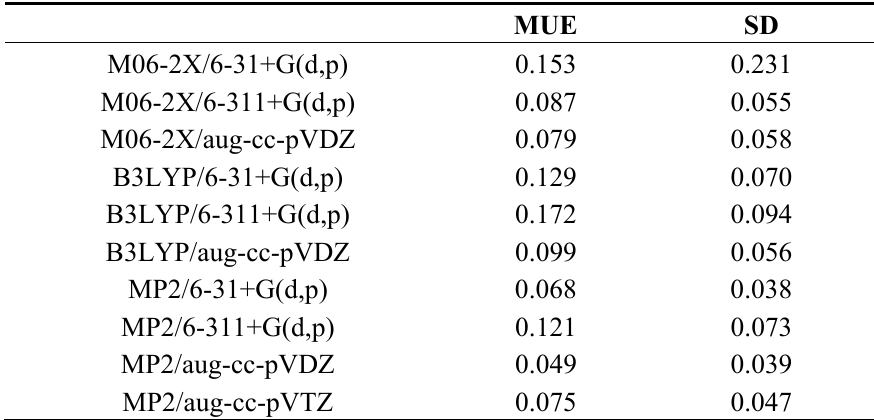
Table 4. Mean unsigned errors (MUE) a and standard deviations (SD) on the KIEs of the 2 reactions at various levels of eleven S N